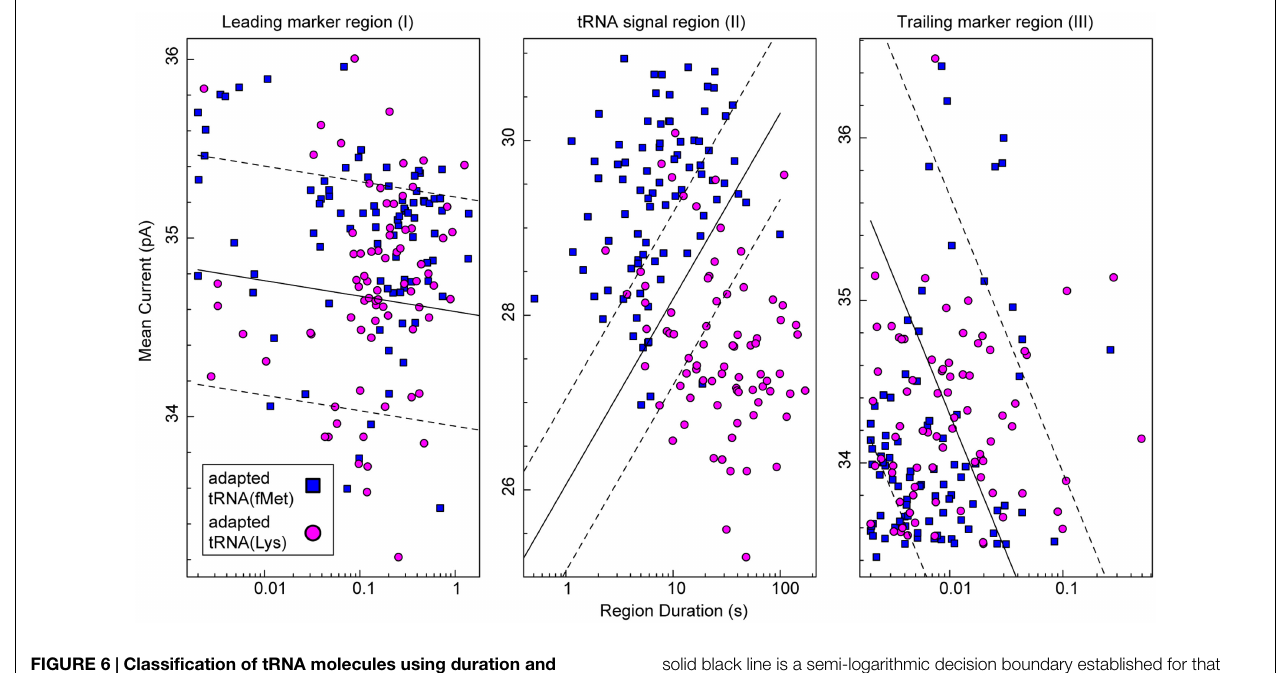
FIGURE 6 | Classification of tRNA molecules using duration and mean ionic for regions I–III of adapted tRNA translocation events . We collected complete ionic current events (approximately 80 for each class) from experiments ( n ≥ 5) using adapted E. coli tRNA fMet (blue squares) or adapted tRNA Lys (magenta circles). In our model ( Figure 5C ), regions I and III correspond to the common leading and trailing marker regions, respectively, and region II corresponds to the intervening RNA-dependent portion of the signal. The x -axis is the duration of a given region and the y -axis is mean current for that region. In each panel, the